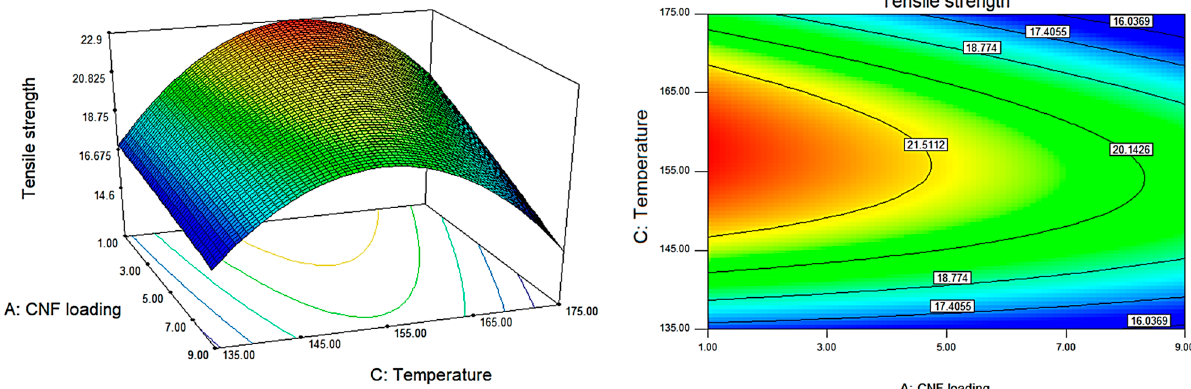
Figure 2. The 3D and response surface contour plots for the dependence of P(HB- co -11% HHx)/CNF bionanocomposite’s tensile strength on CNF loading and temperature as significant factors.